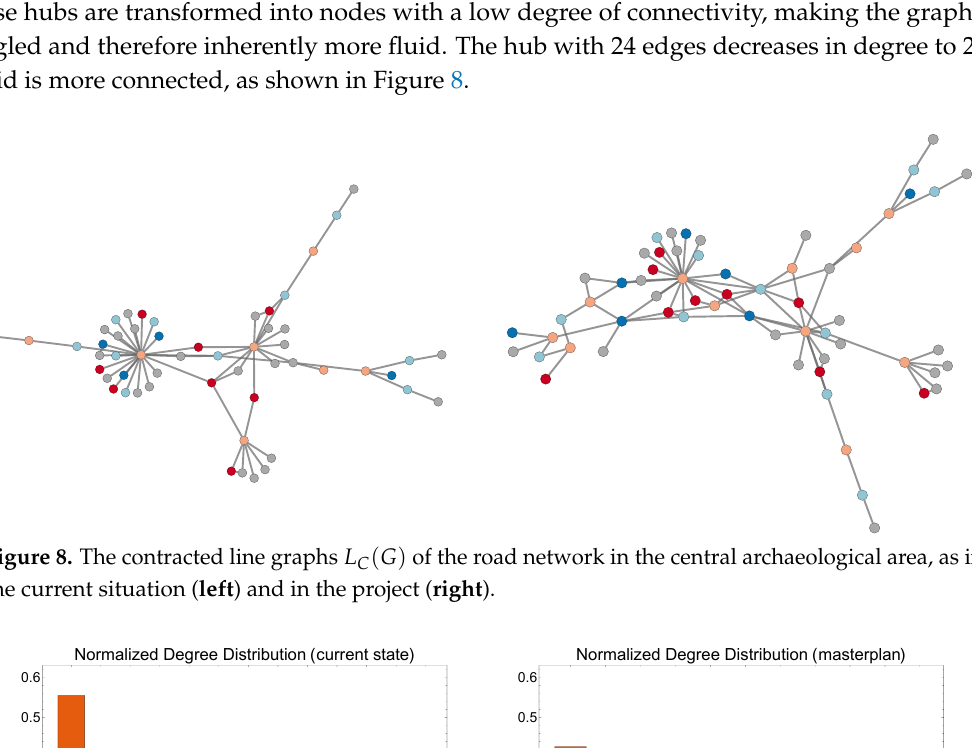
Figure 7. The variables used in the model.